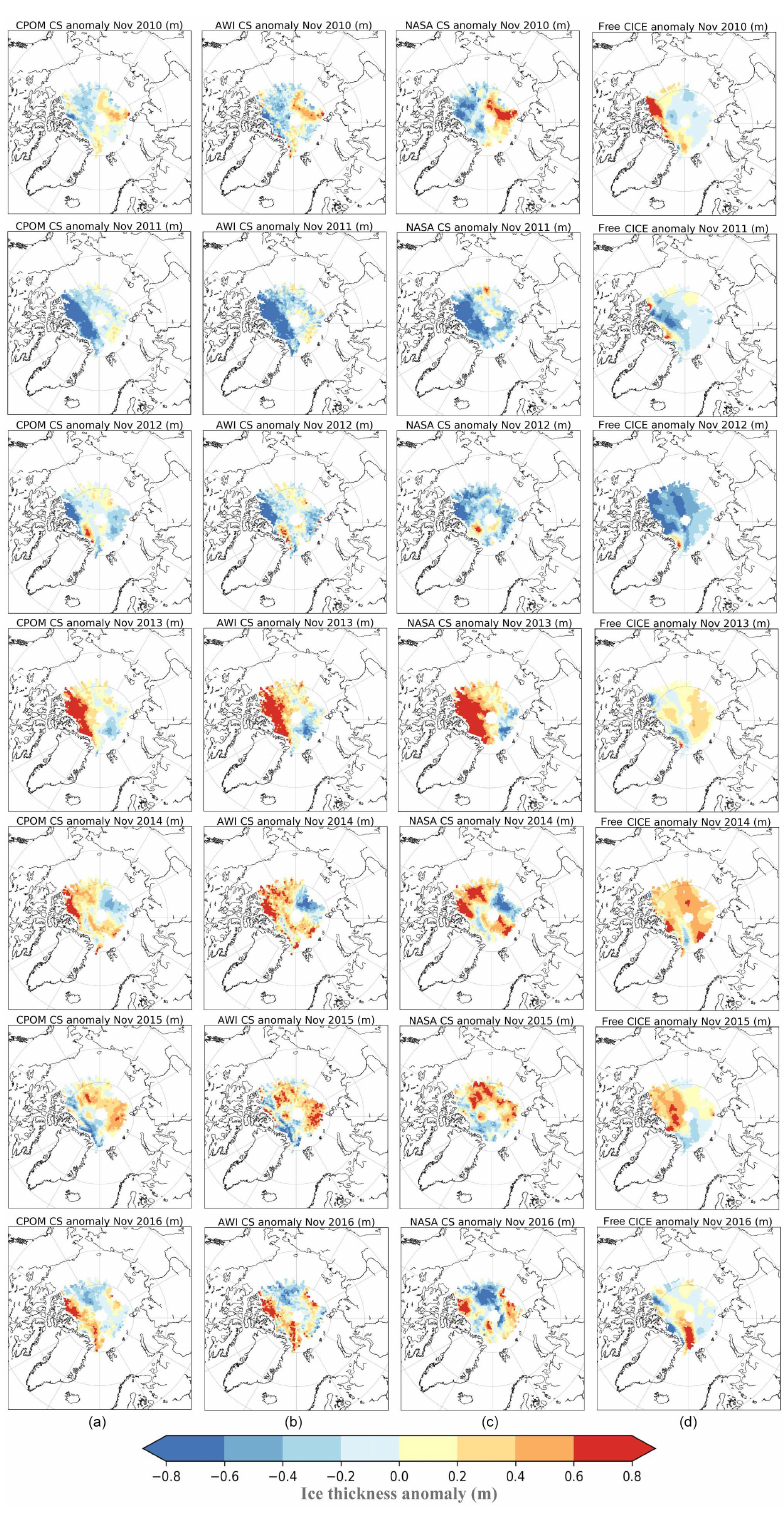
Figure 3. November ice thickness anomaly relative to 2010–2016 in cm based on CryoSat-2 data from UCL CPOM (a) , Alfred Wegener Institute (AWI) (b) and NASA (c) . Grid points with less than 100 individual measurements and a mean sea ice thickness of less than 0.5m are not included. CICE-free thickness anomalies are also shown (d)